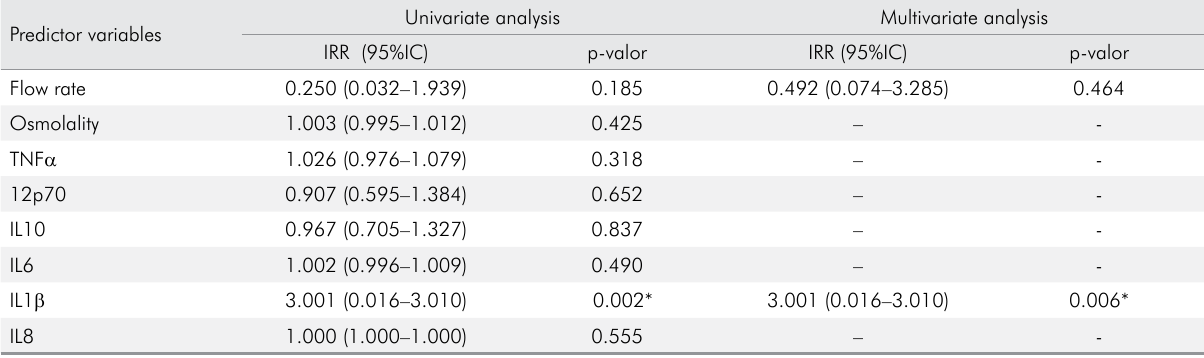
Table 4. Poisson regression analysis to determine baseline characteristics associated with higher GI values after periodontal treatment. Predictor